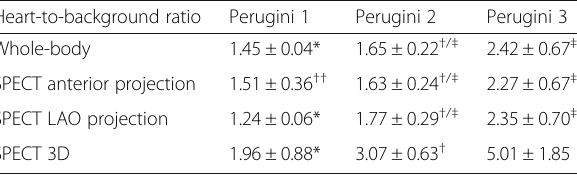
Table 2 Heart-to-background uptake ratio according to the Perugini grade